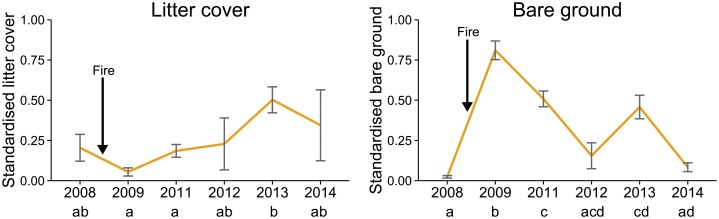
Means and standard errors for bare ground and litter cover in vegetation plots within the fire scar at Kings Park.The fire occurred in January 2009, so the measurements from 2008 are ‘pre-fire’. Pairwise differences are indicated using subscripts, with significantly different pairs not sharing the same letter.